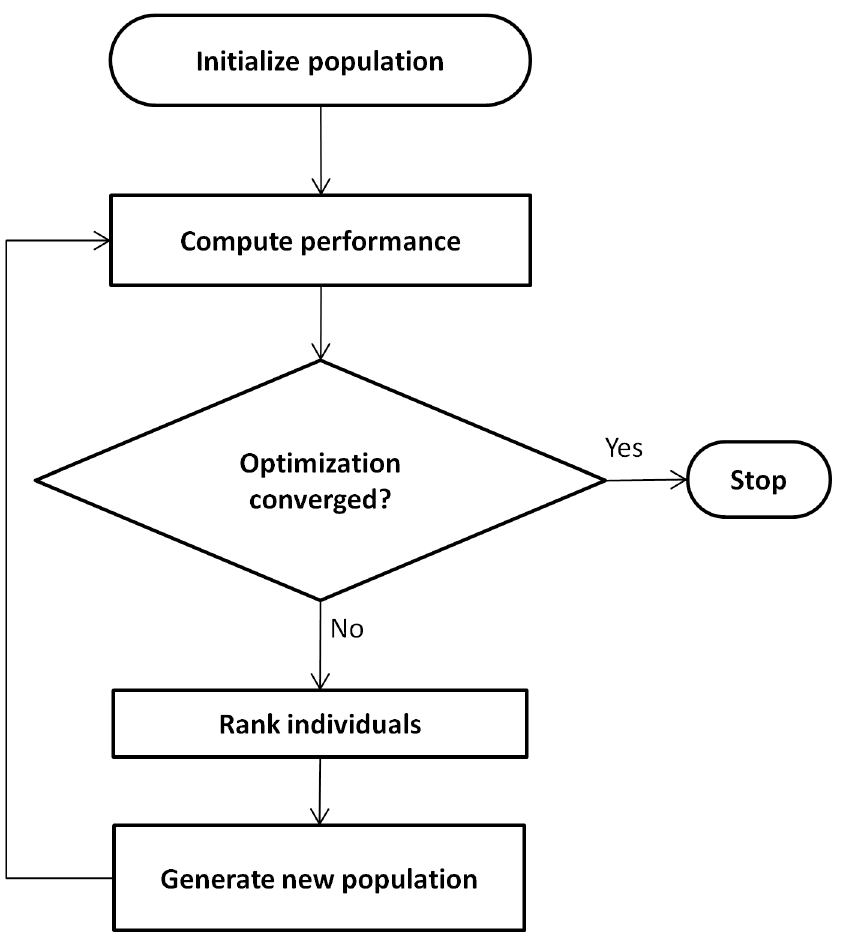
Fig 3. Optimization algorithm. A genetic algorithm was used to compute the muscle excitation parameters that satisfied the performance criteria. See S2 Appendix for a detailed description of each step.